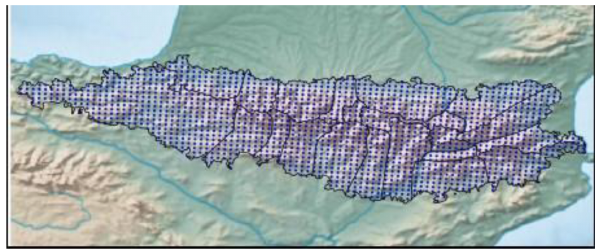
Figure 2. The observational grid that encompasses 1622 points over the CLIMPY area.